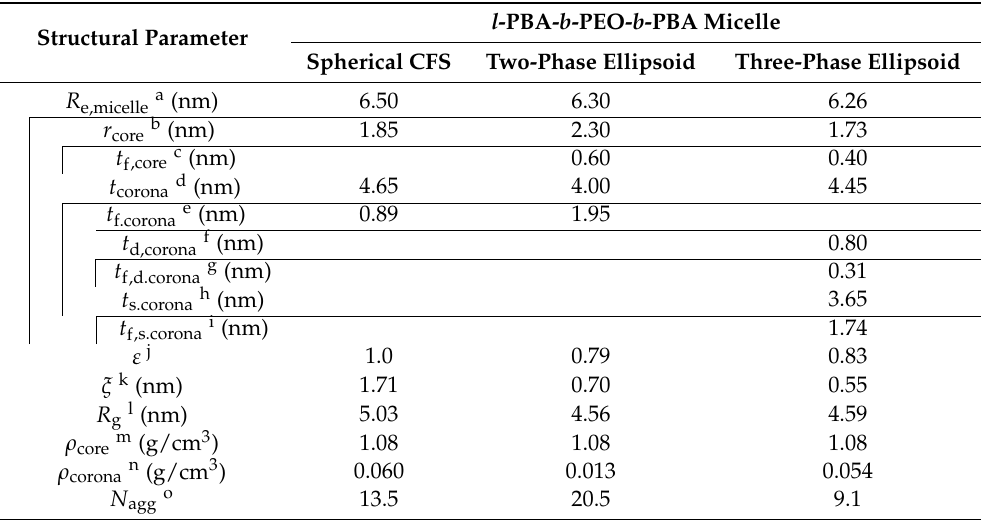
Table 3. Structural parameters of the l -PBA- b -PEO- b -PBA micelle obtained from the quantitative analysis of scattering data with various model